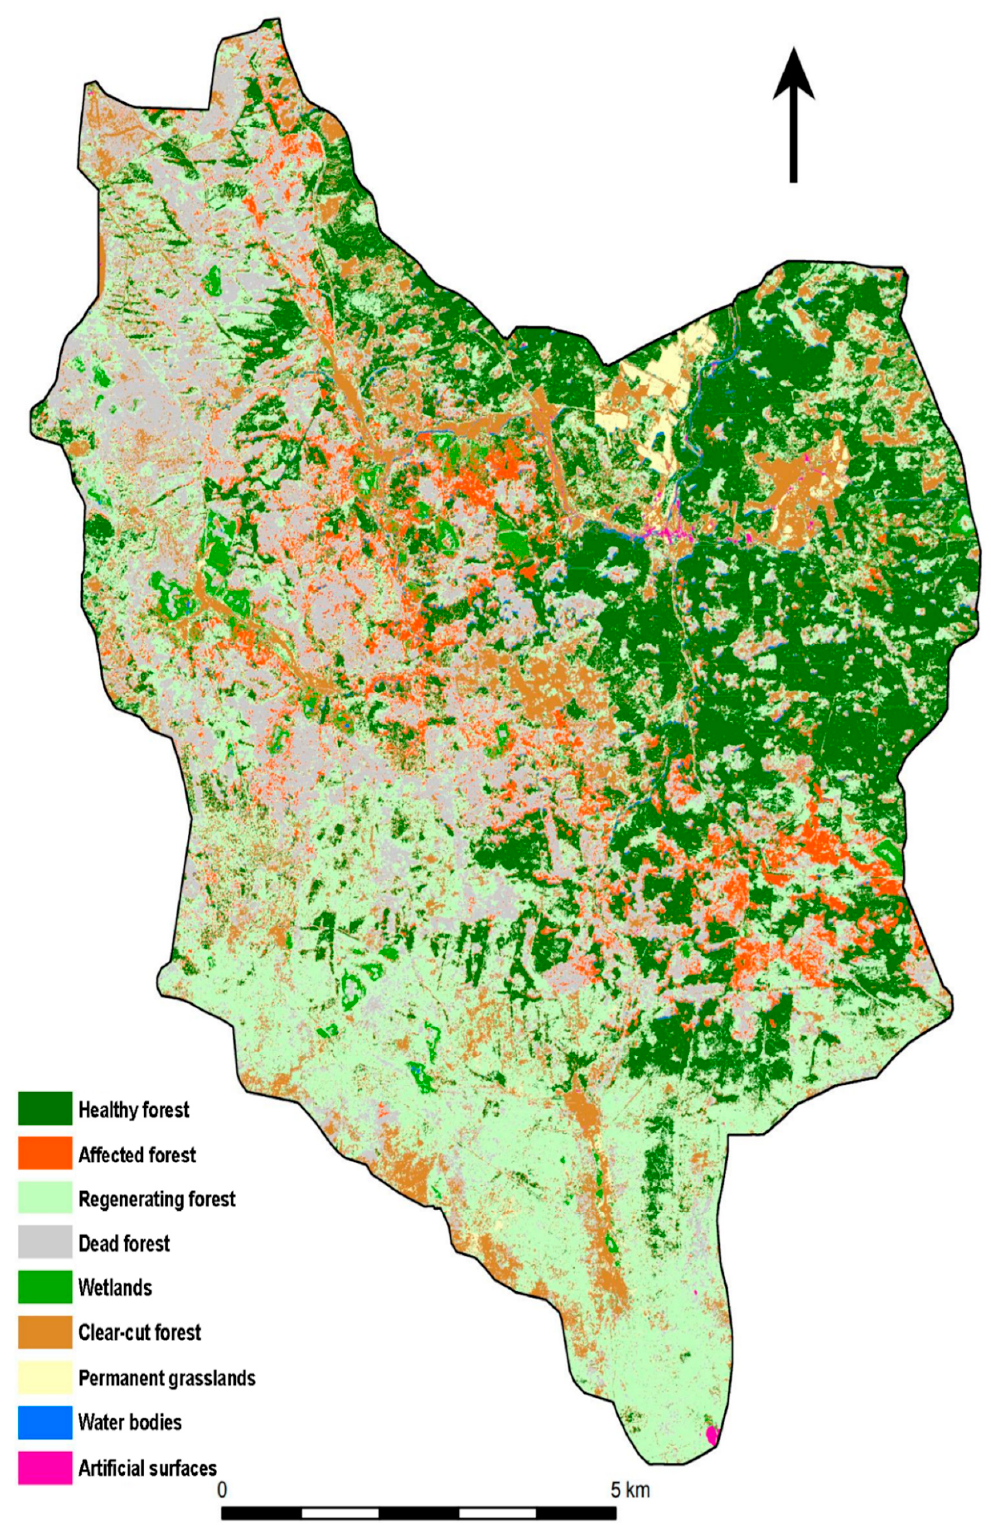
Figure A11. Classification NN, WorldView-2, 2016, NP Sumava.